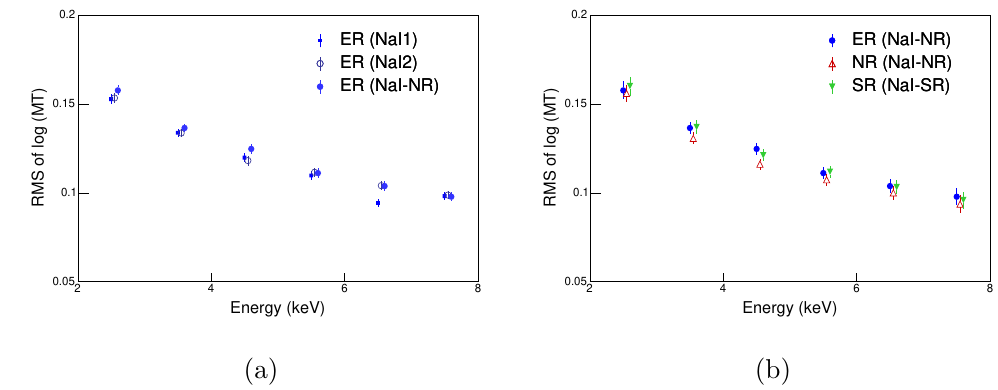
Figure 3 . (a) The recoil energy dependence of the RMS values of LMT distributions for ER- induced signals in the crystals that were used for the underground WIMP-search and the above- ground calibration data samples. All of the ER samples have RMS values that are equal within the measurement errors, which indicates that the discrimination power is the same for the di(cid:11)erent crystals. (b) The RMS values of the LMT distributions for the ER, NR and SR calibration samples. Since the RMS depends on the crystal light yield, and the crystals used to produce the calibration samples have similar light yields, we expect each sample to have the same RMS at each energy.